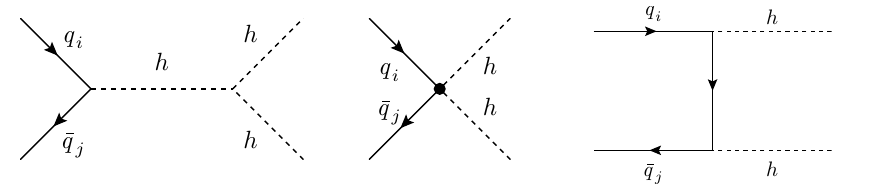
Figure 5 . Feynman diagrams for the qqA Higgs pair